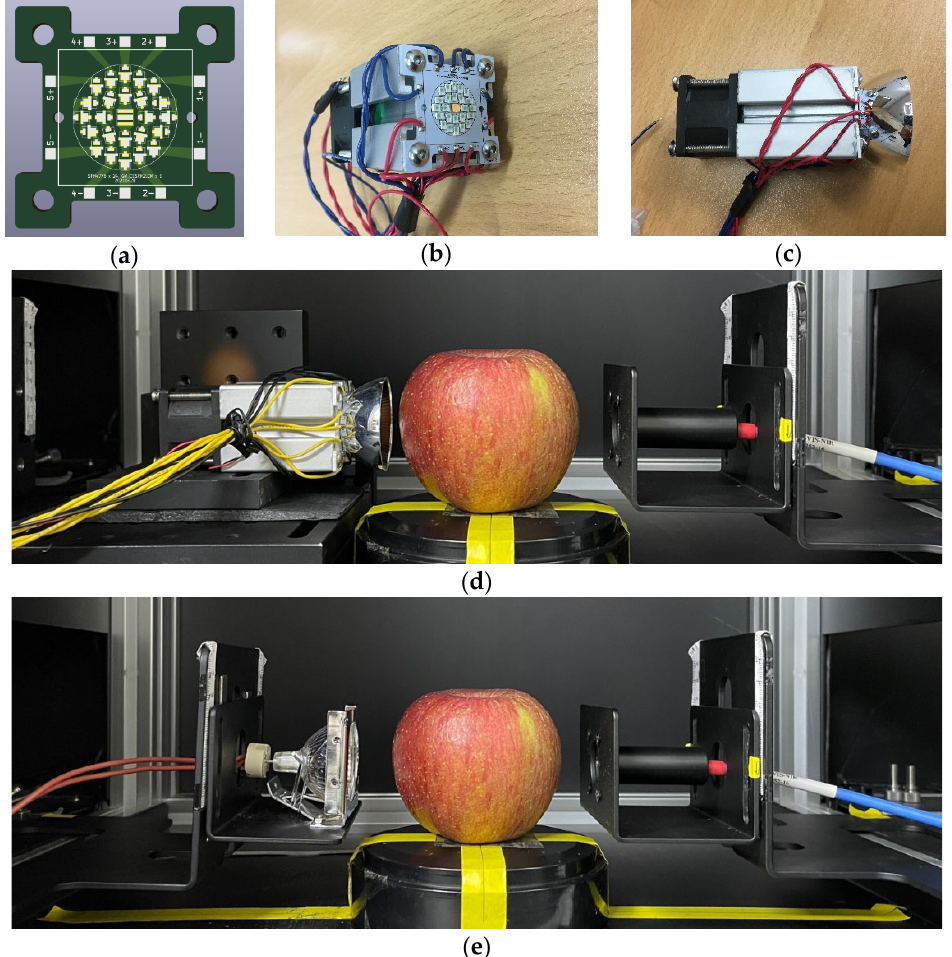
Figure 2. ( a ) MCPCB design for 24 pc-NIR LEDs and a warm white LED; ( b ) LED module assembly, AL extrusion, and blower fan; ( c ) Reflector attachment for concentrating the Vis/NIR radiation; ( d , e ) spectral data acquisition apparatus for the SSC estimation of apple using the LED module and TH